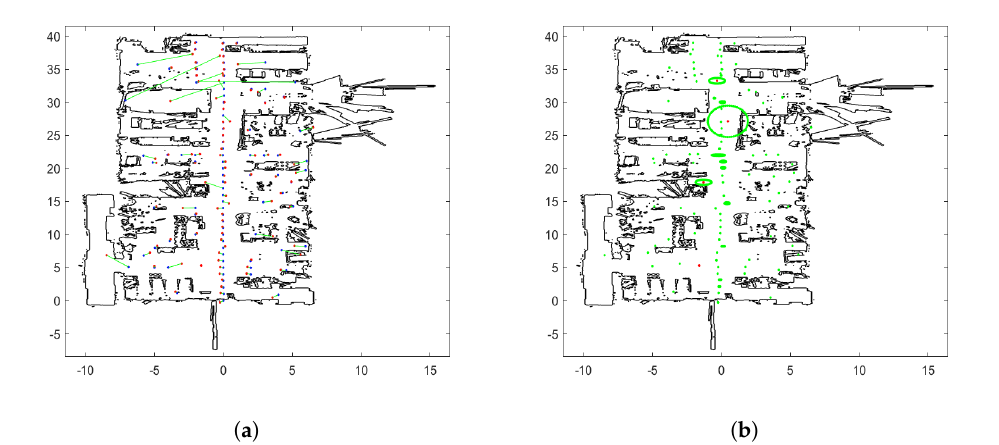
Figure A2. Static case results for GoT at 2m altitude. ( a ) Estimated positions from GoT (red) vs. ground-truth (blue) with connecting line (green). ( b ) Estimated positions from GoT (red) and standard deviation ellipsoids (green).